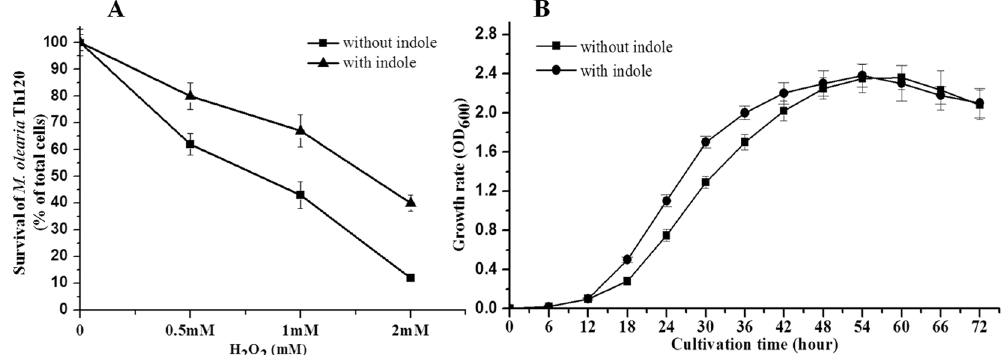
Figure 1. Function of indole for M. olearia Th120 in iron deficient and H 2 O 2 conditions. ( A ) The survival of M. olearia Th120 upon H 2 O 2 treatment with or without indole. ( B ) M. olearia Th120 growth rate assay under conditions of ferric infertility (100 μ M 2,2 ′ -dipyridyl). Error bars represent the standard deviations of three